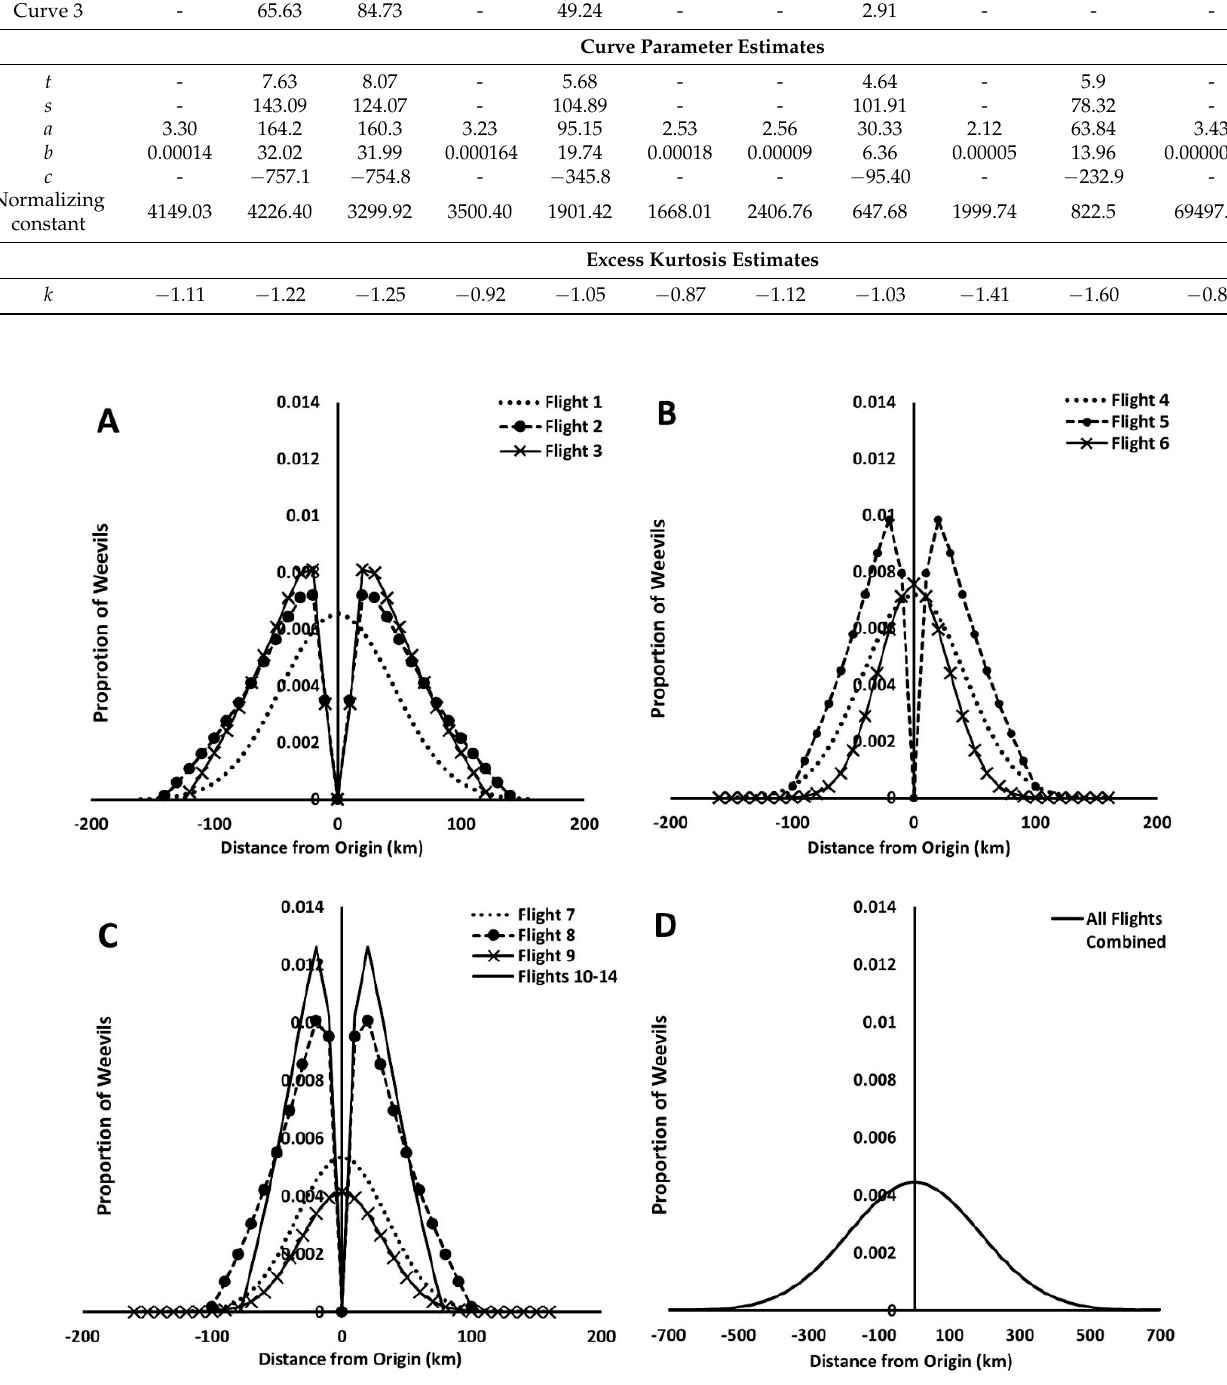
Figure 5. Redistribution kernel graphs for ( A ) flights 1–3, ( B ) flights 4–6, ( C ) flights 7–9 and 10–14 combined, and ( D ) all flights (1–14) combined. Graph equations were parameterized and normalized and using estimates from Table 2. All curves exhibit platykurtosis.